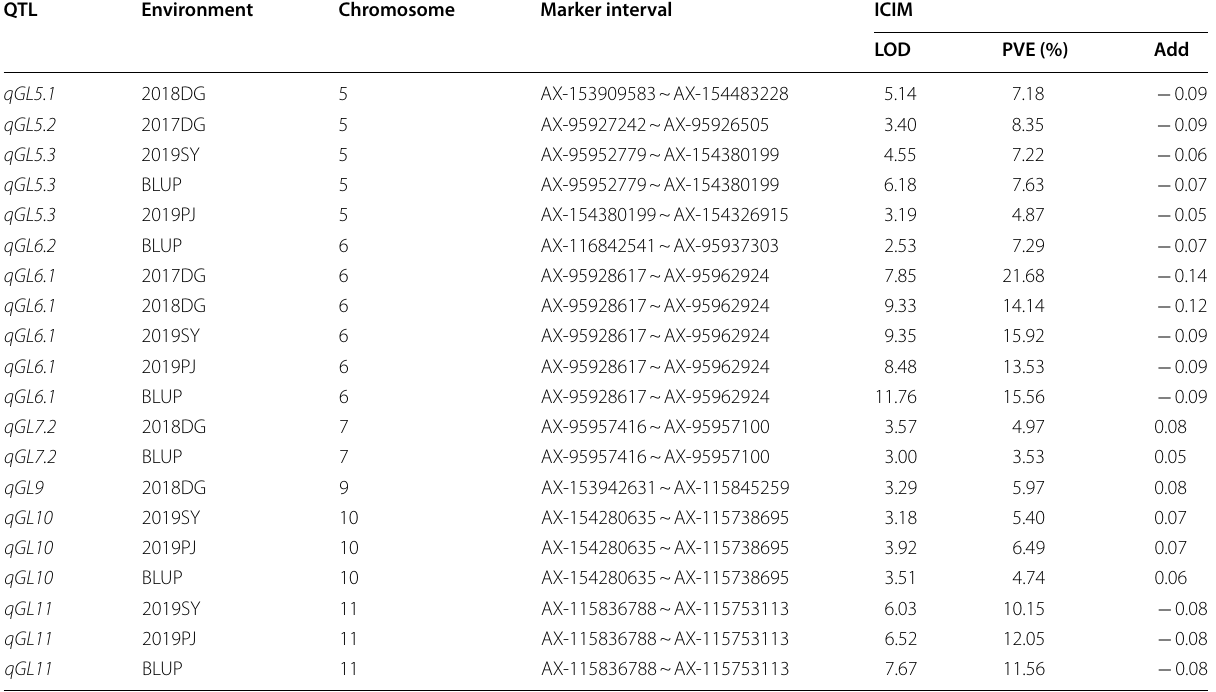
Table 1 QTLs for grain length in rice by single environment